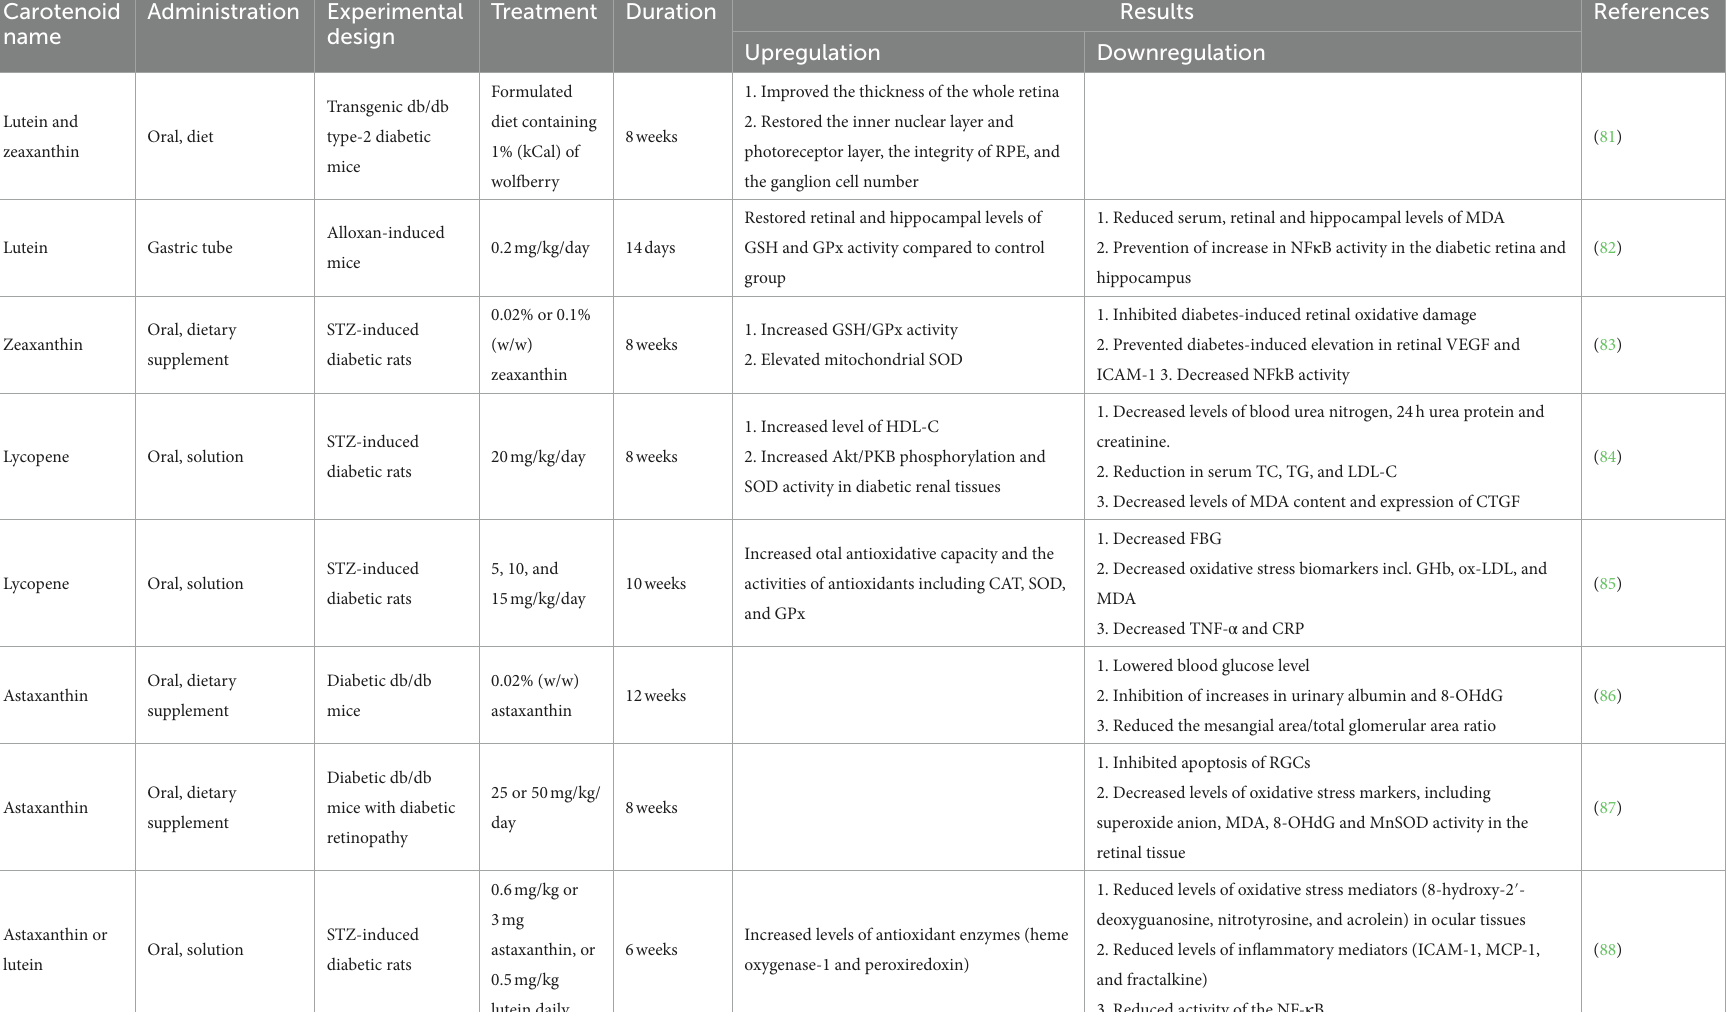
TABLE 4 Protective effects of carotenoids against diabetic complications—animal study evidence. Carotenoid